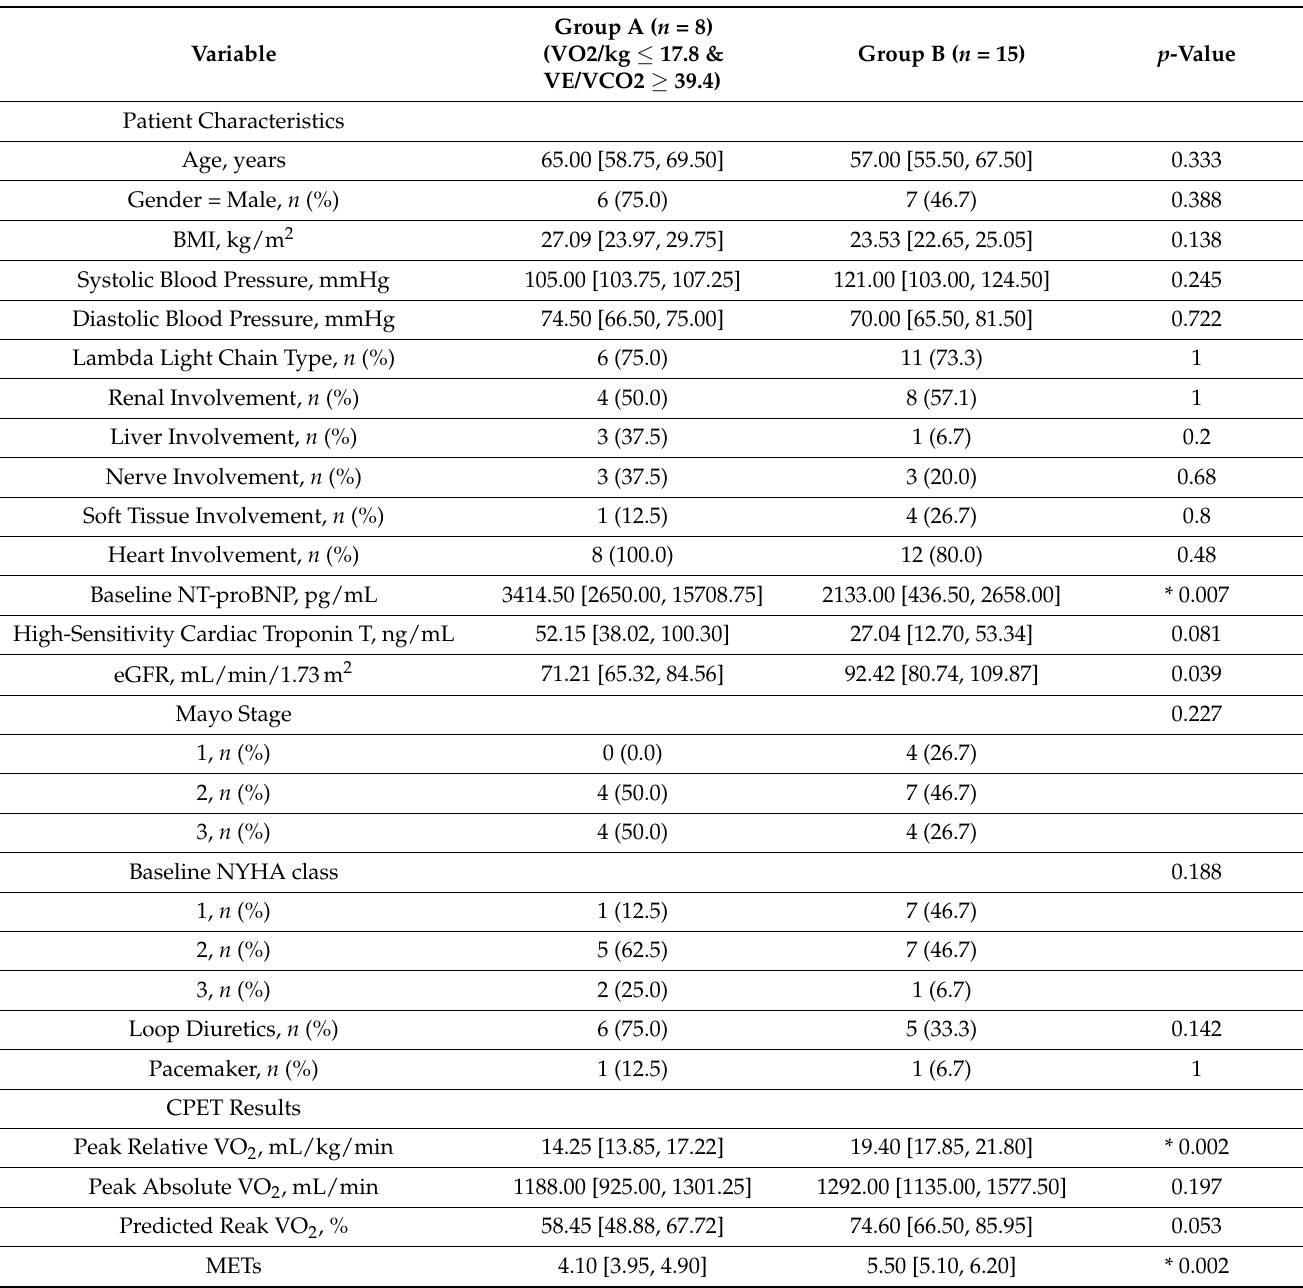
Table 2. Characteristics of patients according to cardiopulmonary exercise parameters suggestive of severe functional